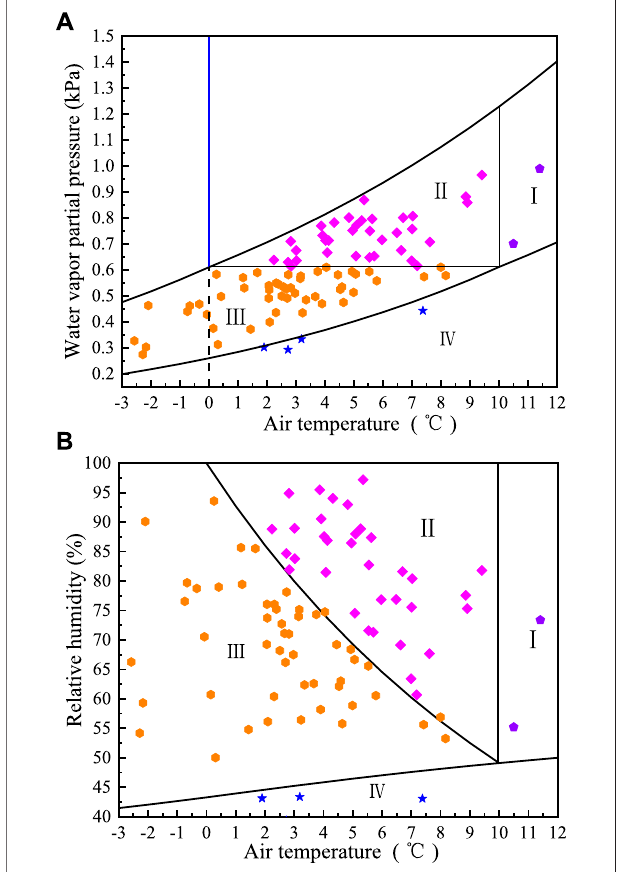
FIGURE 3 | Classi fi cation of the frosting types in Nanjing in the three- phase diagram and temperature – humidity diagram: (A) three-phase diagram of water; (B) temperature – humidity